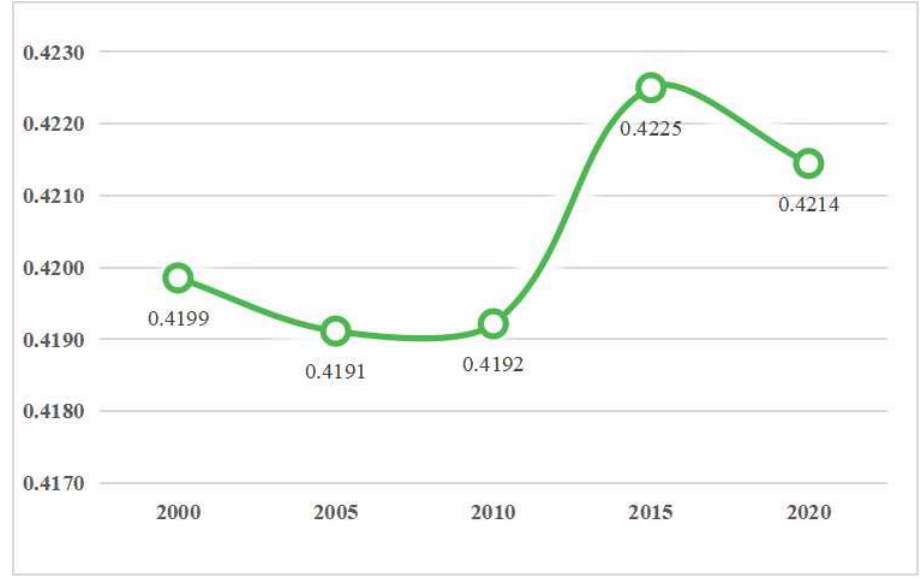
Figure 3. The EQI of the Baiyangdian basin from 2000 to 2020.